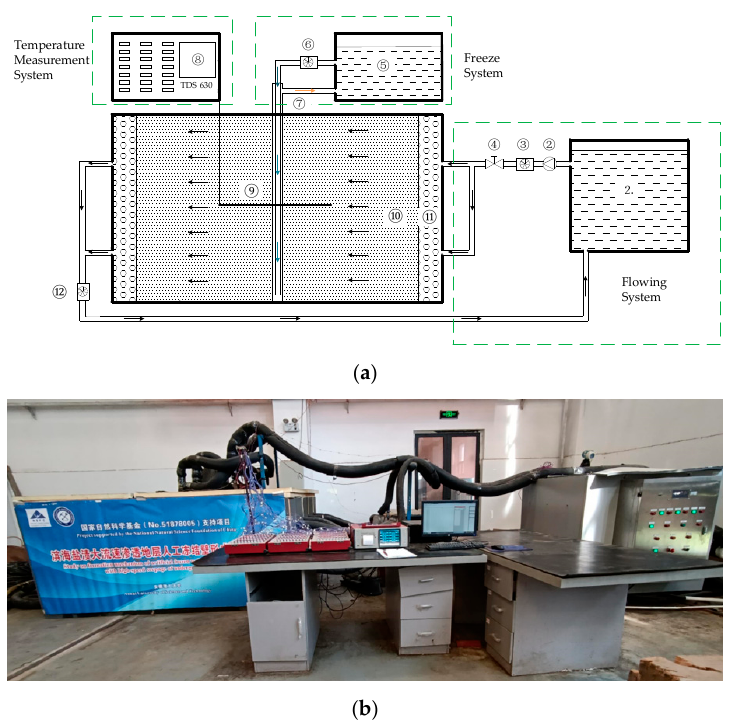
Figure 4. Test system diagram: ( a ) Schematic diagram of test system. 1, Constant temperature water tank; 2, constant pressure pump; 3, inlet flowmeter; 4, ball valve; 5, freezing machine; 6, alcohol flowmeter; 7, freezing pipes; 8, data acquisition instrument; 9, temperature measuring surface; 10, porous media; 11, buffer layer; 12, outlet flowmeter. ( b ) Photograph of the test system.